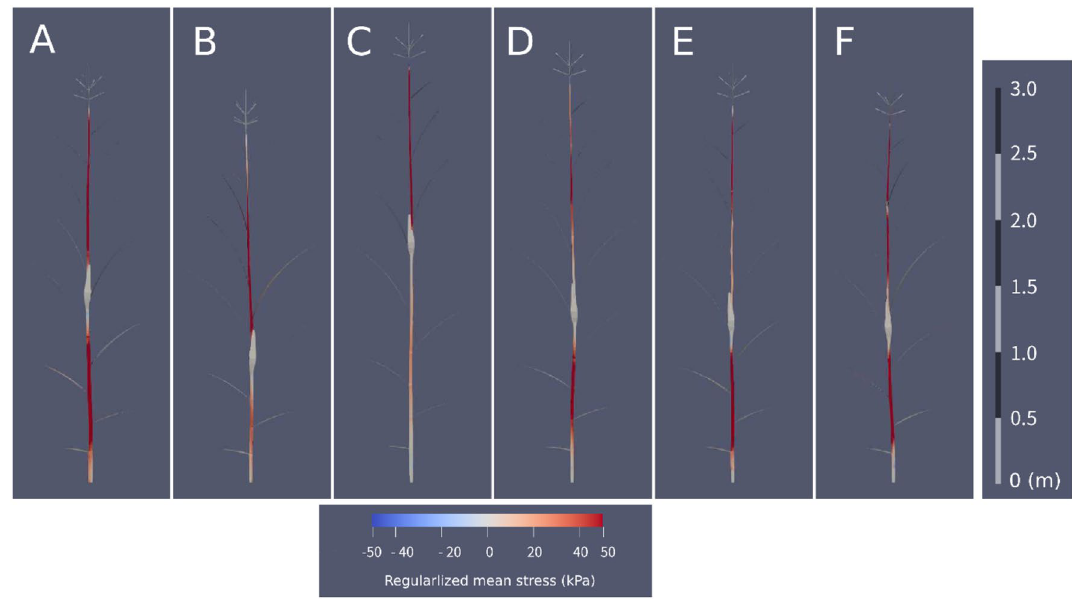
Figure 5. Eigenmodes simulated by finite element analysis. Fundamental modes and contour map of the regularized mean stress estimated for ( A ) KD580, ( B ) LG2533, ( C ) NS115 ( D ) Taranis, ( E ) Flec, and ( F ) P9027, respectively. The deformation vector is regularized so that the norm is equal to 1.0, and mean stress is associated with the displacement. Although the hot-spots are visible in Fig. 1A,B, the stress levels are distinctly different for each mechanical/morphological